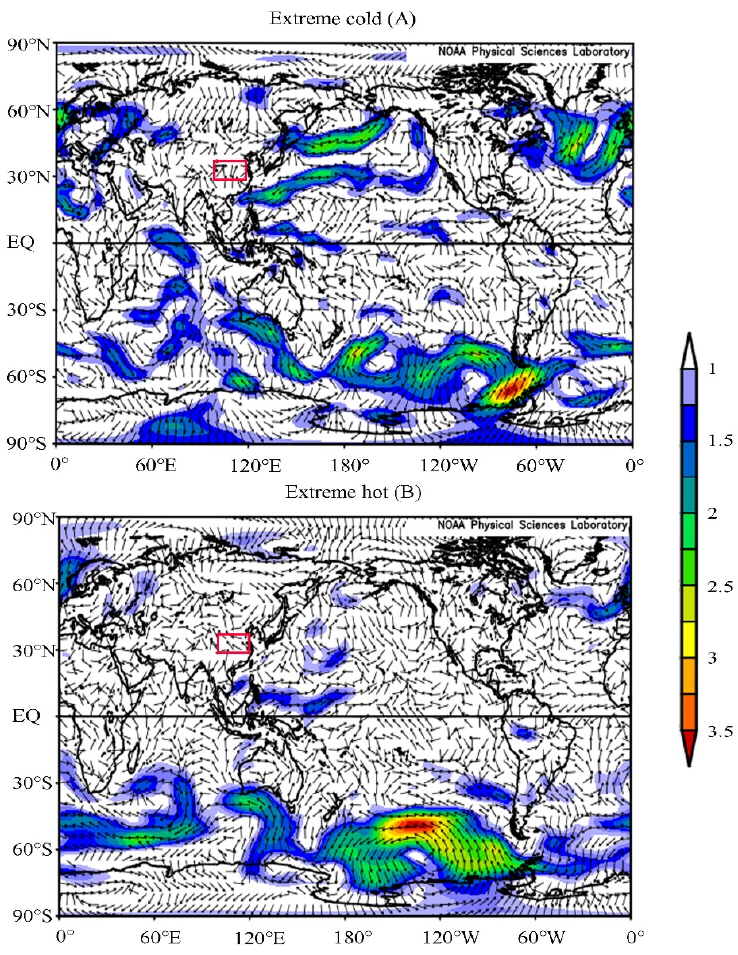
Figure 13. The changes in vector wind field during the May–June mean temperature in the Tongbai Mountain area in extremely hot years ( A ) and extremely cold years ( B ).